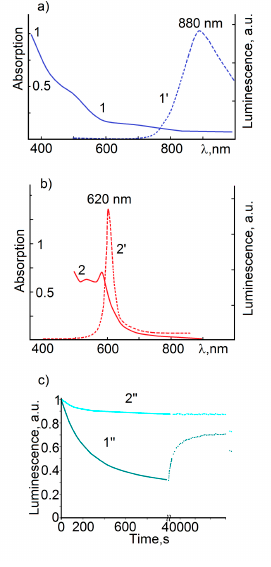
Figure 3. UV-Vis absorption (1, 2), photoluminescence spectra (1’, 2’) and luminescence photodegradation (1”, 2”) of colloidal Ag 2 S/TGA QDs, prepared in various synthesis